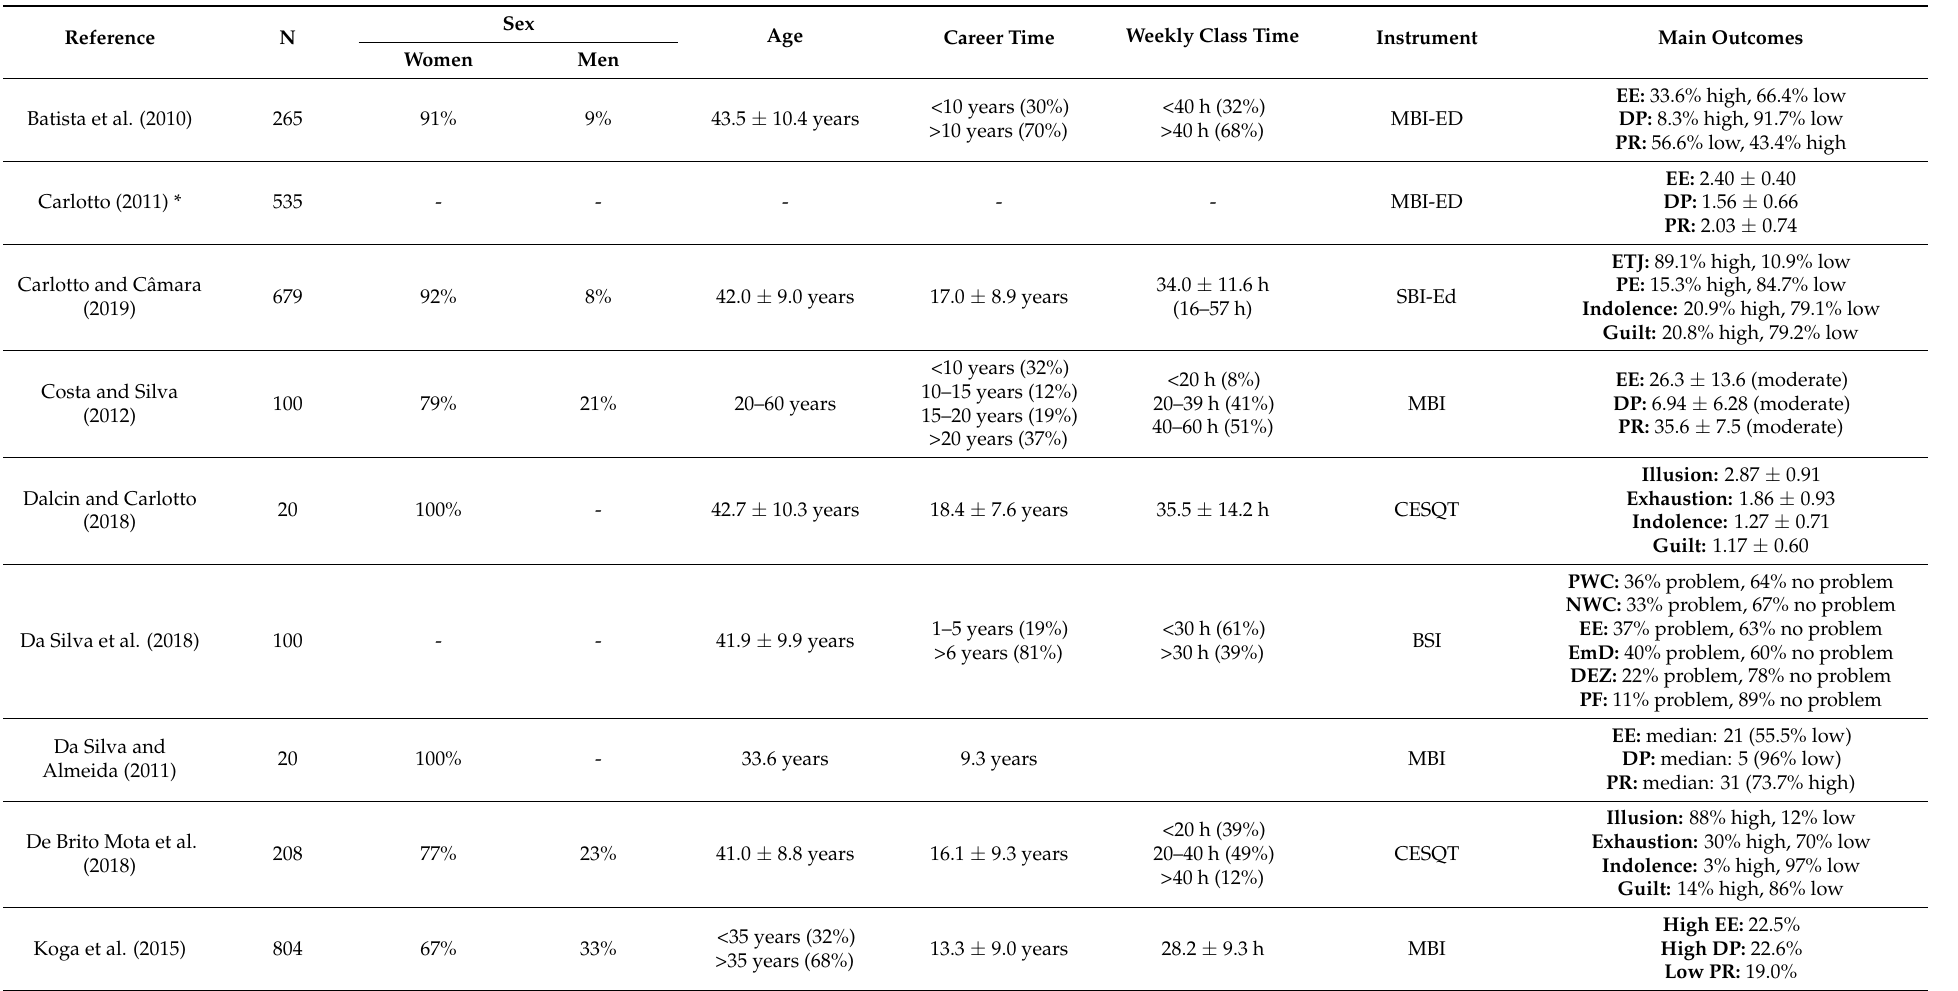
Table 1. Characteristics and main outcomes of the studies included in the systematic